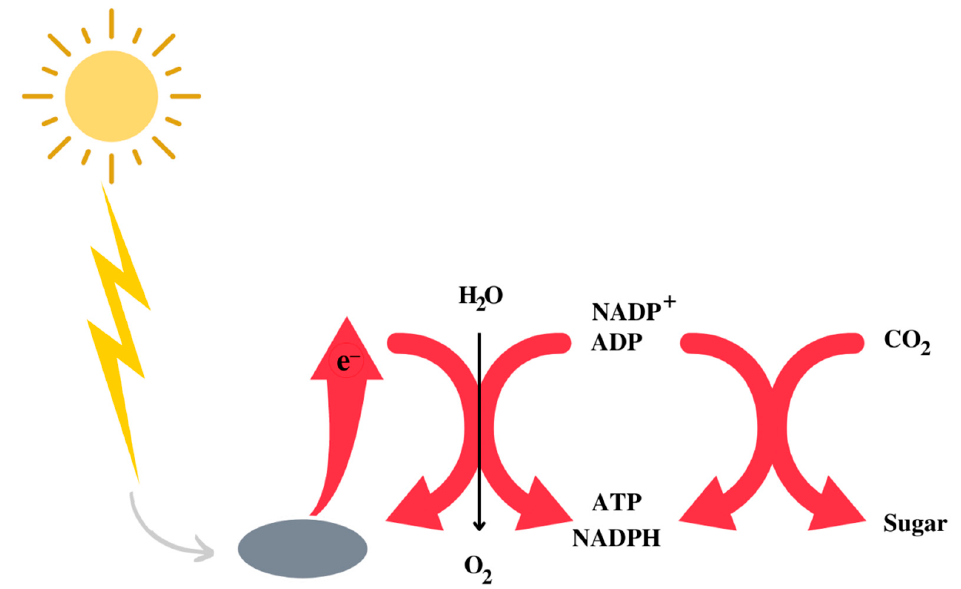
Figure 1. Schematic representation of the utilisation of the sun energy to obtain a form of metabolically utilisable energy by living beings.